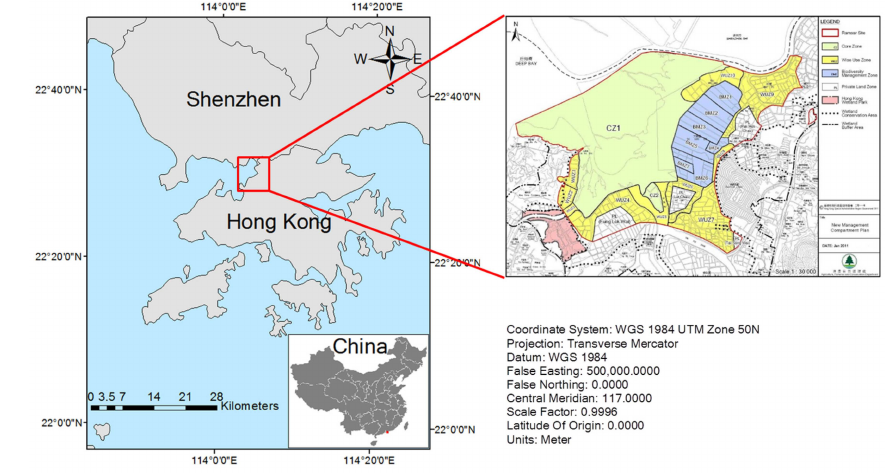
Figure 1. The location of the study